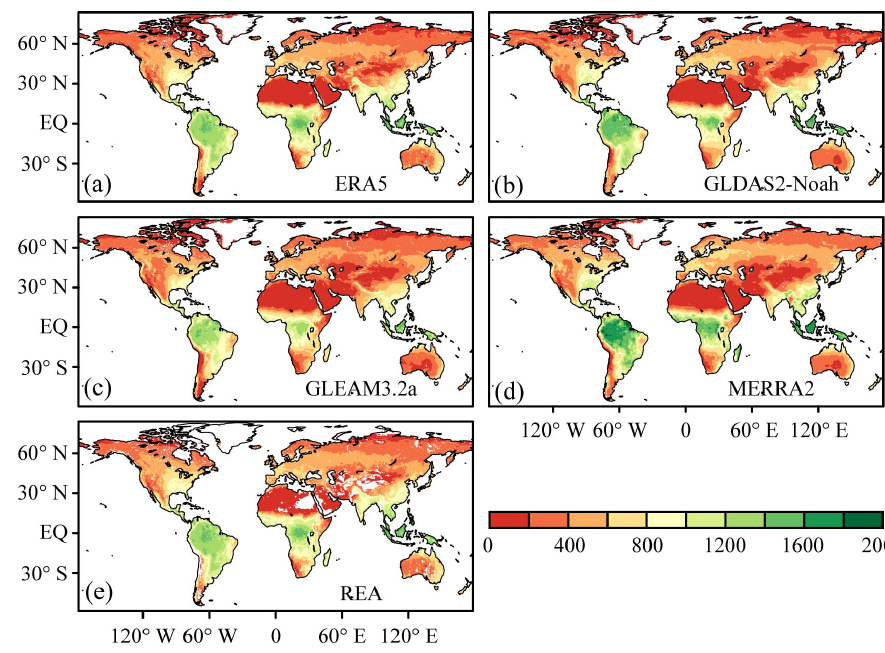
Figure 8. Spatial distribution of annual mean land evaporation for the period 1980–2017 (unit: mm).